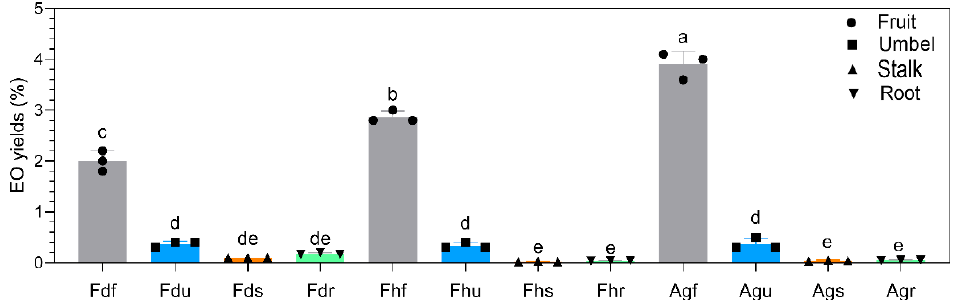
Figure 3. The evaluation of EO yields of all samples. Different letters indicate significant differ- ences ( p < 0.05)